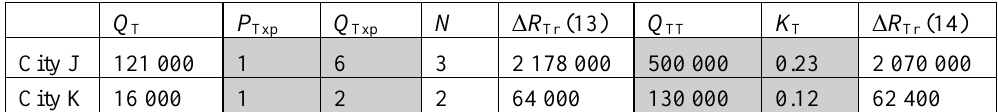
Table 3. Additional Calculation of Revenue from Traffic Flow Δ R